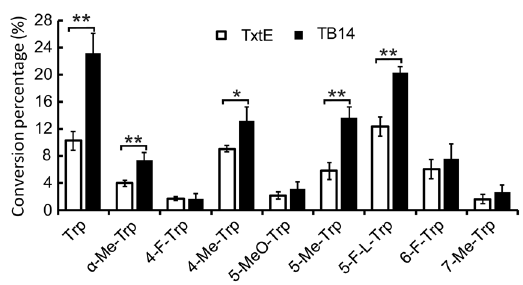
Figure 3. TxtE and TB14 nitrated Trp and its analogues to varying degrees. The reactions were prepared as described previously and incubated at 20 °C, 300 rpm for 45 minutes. All experiments were repeated at least three times. Substrates showed significant difference in the TxtE and TB14 reactions were indicated with * P < 0.05 or ** P <